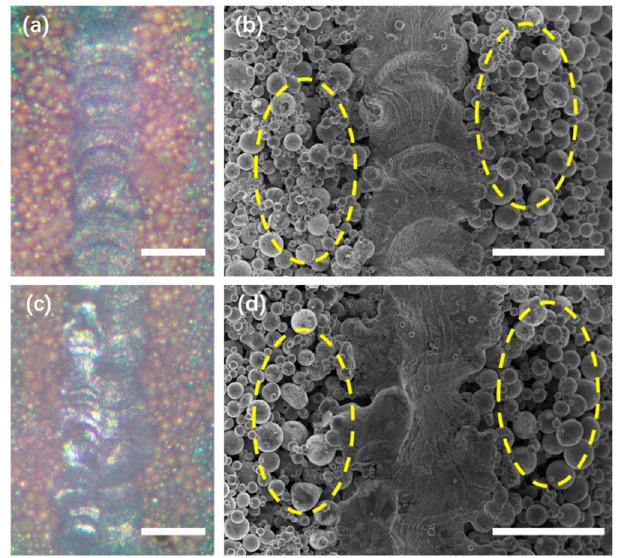
Figure 4. Morphology of single track and dual track under stable melting mode in Figure 3e: ( a , b ) Optical microscope and SEM image of a single track, ( c , d ) Optical microscope and SEM image of a pair up-down melted track where the hatch distance is 50 μ m. The yellow dashed circles indicated the sintered powder at two sides of printed track. All scale bars = 100 μ m.